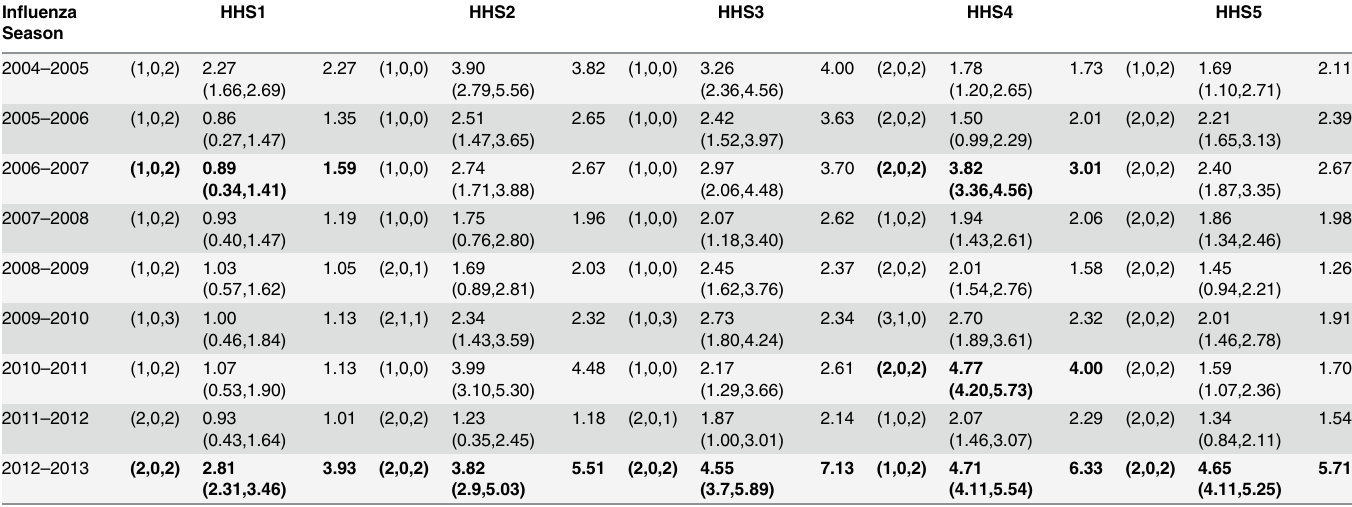
Table 1. Last Week ILI rate prediction for HHS regions 1 – 5 from influenza seasons 2004 – 2005 to 2012 – 2013.